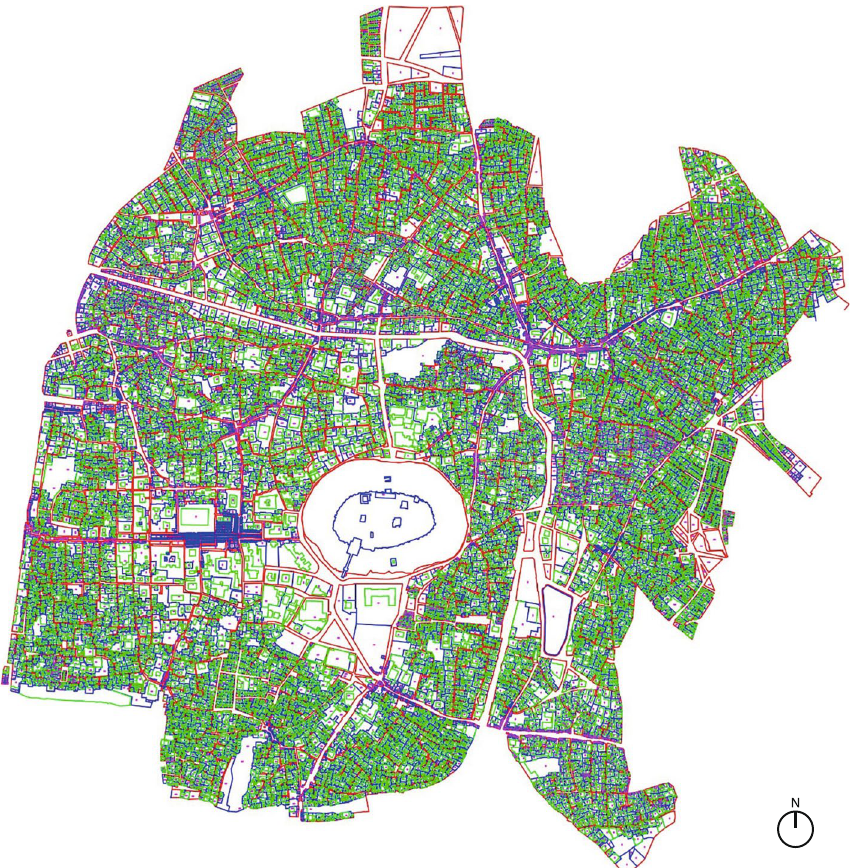
Fig. 2 Selected Digitised 1927–1931 Maps of Aleppo (Source: GTZ and DOCA